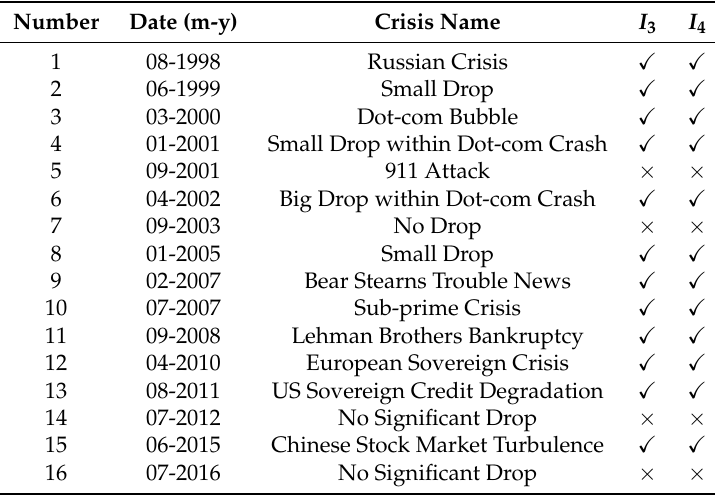
Table 2. Financial Drops vs. Predictive